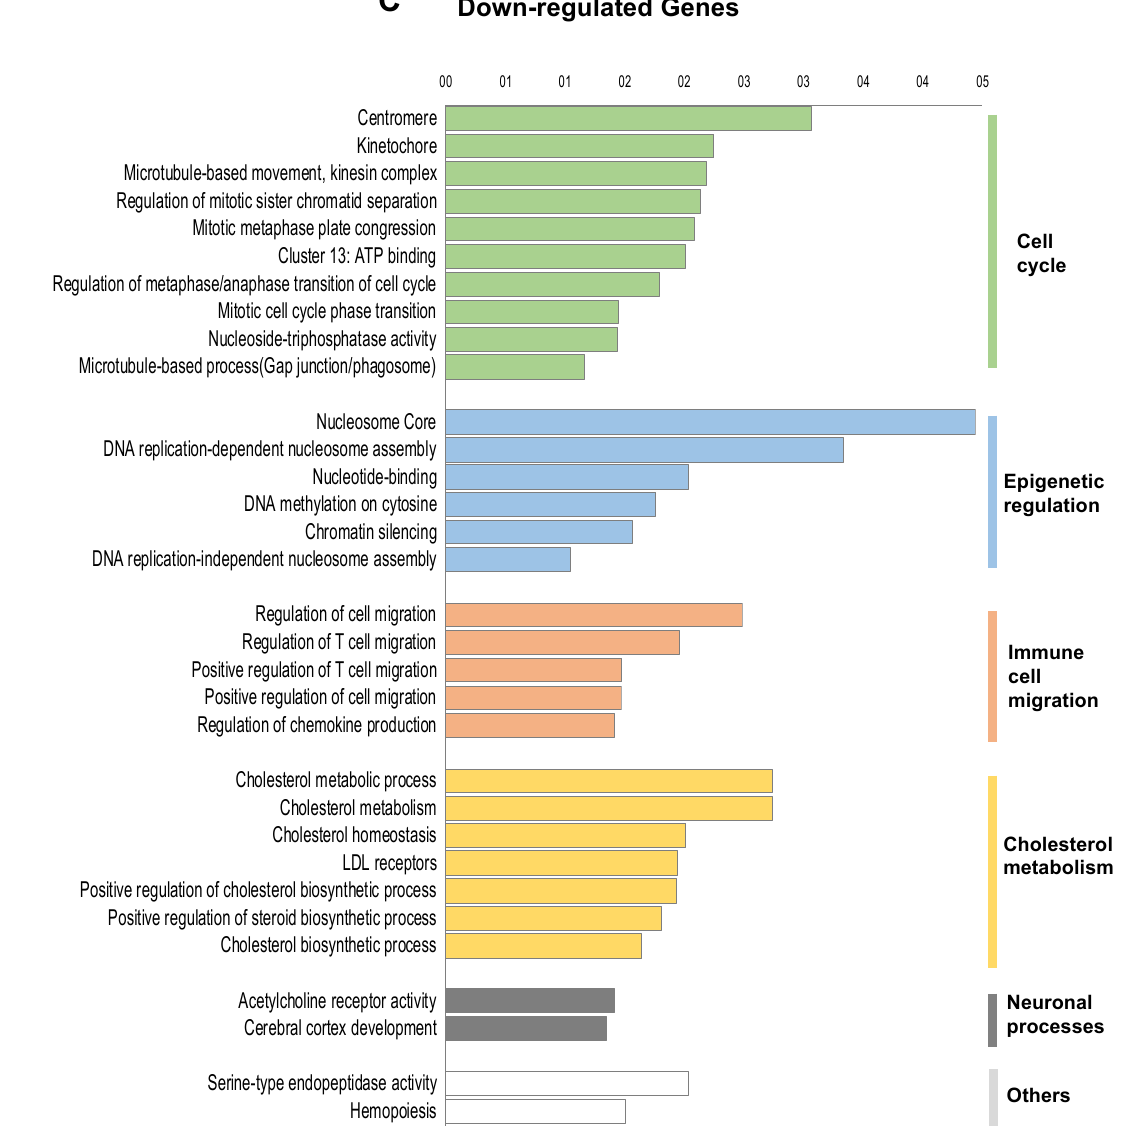
Figure 2. Functional annotation of differentially expressed genes in FOXE1-overxpressing cells. RNAseq analysis was performed on total RNA from FC55 and control cells. ( A ) Pie chart of differentially expressed genes (DEG), considered with a ± 2-fold change (FC) and p ≤ 0.05 cut-off and analysed by Gene Ontology (GO). A total of 750 DEG resulted as being regulated, of which 469 (62.5%) upregulated and 281 (37.5%) downregulated. Functional categories were significantly enriched among genes that were either ( B ) upregulated or ( C ) downregulated. Functional categories (highlighted on the right in vertical groups) were obtained by clustering the functional annotation contained in the web-based DAVID database. To perform clustering, we used multiple annotations—namely, gene ontology for biological processes, molecular function and cellular components (GO_DIRECT), pathways, protein interactions, protein domain and tissue expressions. Enrichment scores are plotted only for clusters containing multiple terms with p < 0.05.